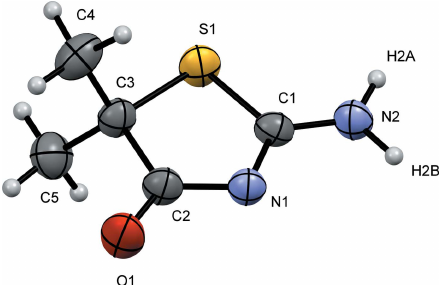
Figure 1 A view of the molecular structure of the title compound, with the atom labeling. Displacement ellipsoids are drawn at the 50% probability